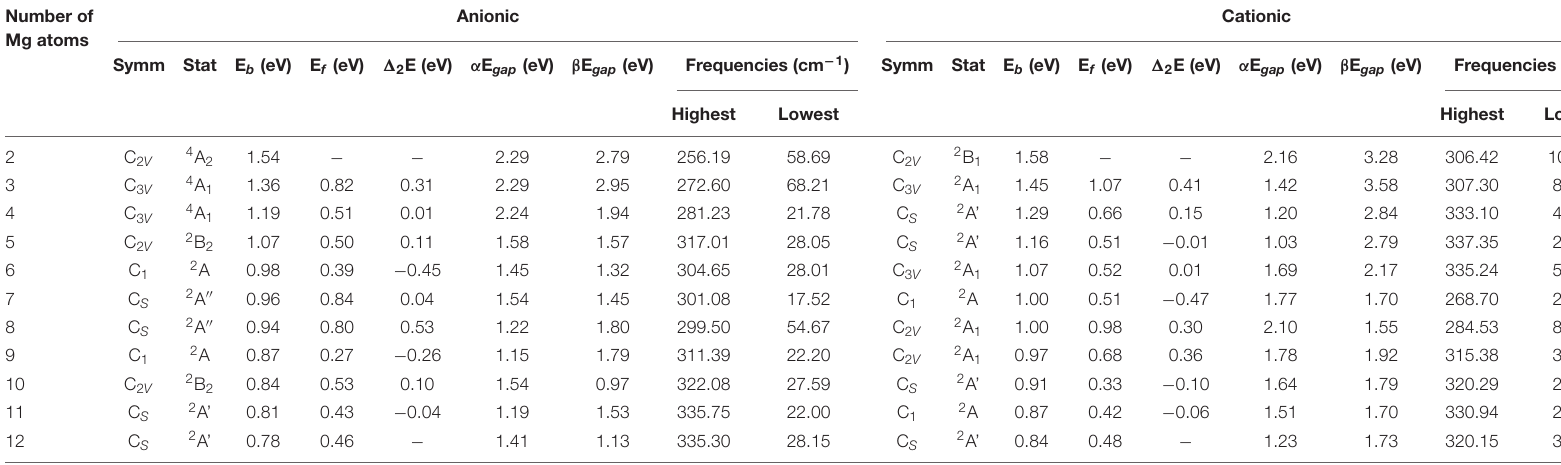
TABLE 2 | NCP of the ground state of SiMg − 1 n ( n = 2–12) clusters. Number of Mg atoms